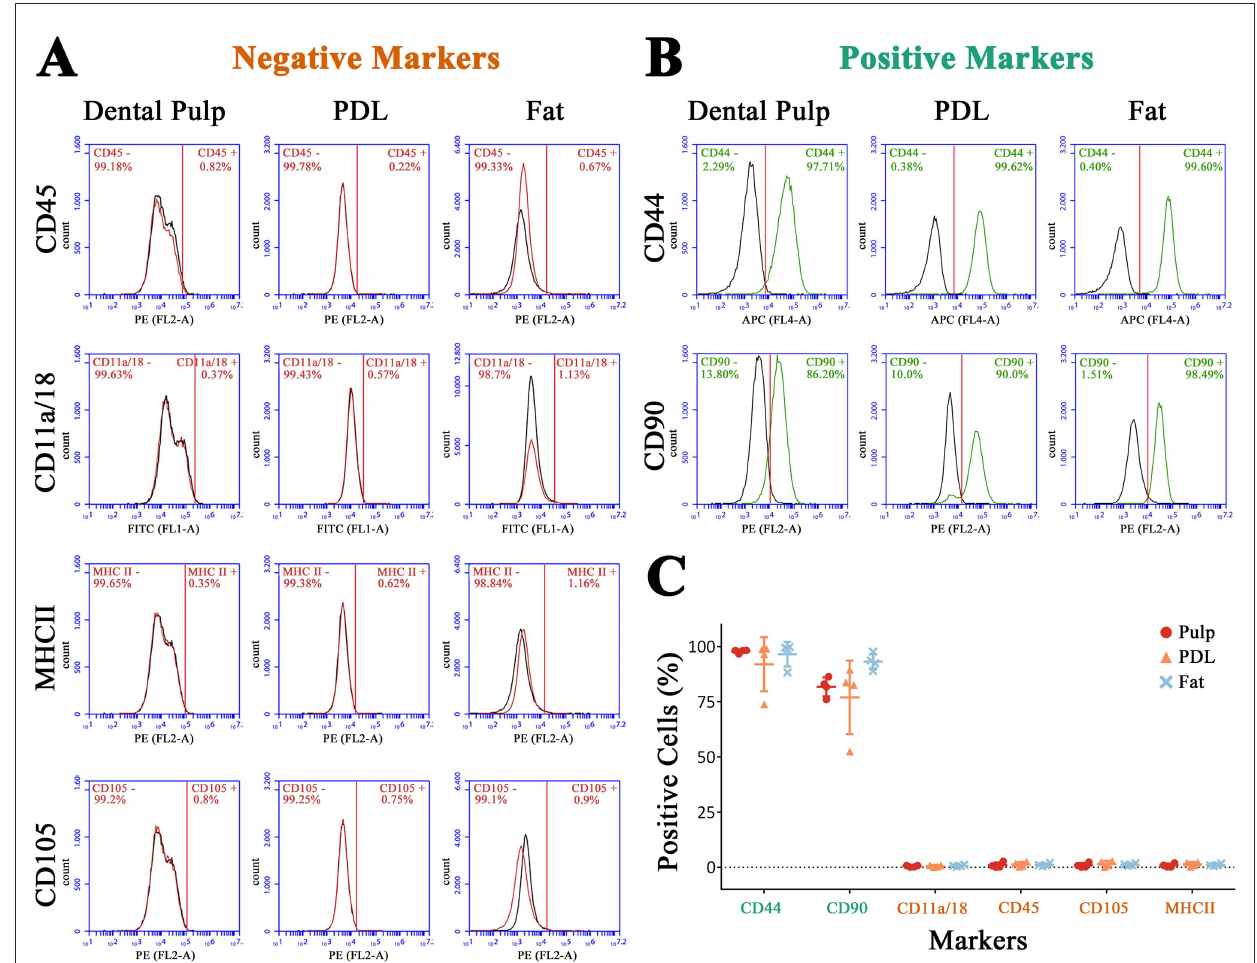
FIGURE7 Flow cytometry for negative markers (A) and positive markers (B) of one donor exemplary. In (C) the ratio of positive cells for all donors is shown.